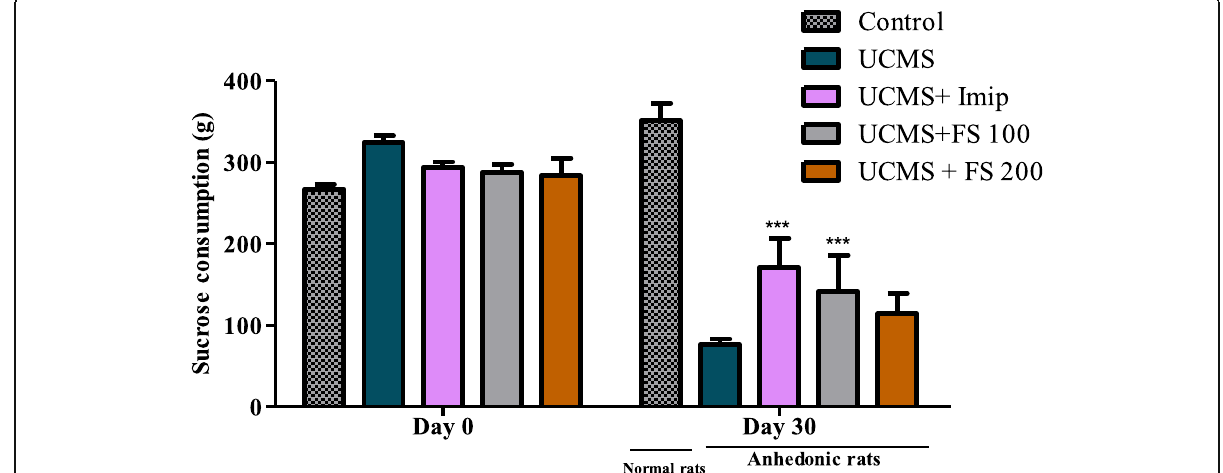
Fig. 5 Effect of hydromethanolic extract of F. sycomorus on anhedonia. Sucrose consumption before (Day 0) and after (Day 30). UCMS: unpredictable chronic mild stress; Imip: imipramine, FS: Ficus sycomorus extract. *** P <0,001 vs. equivalent animal group at day